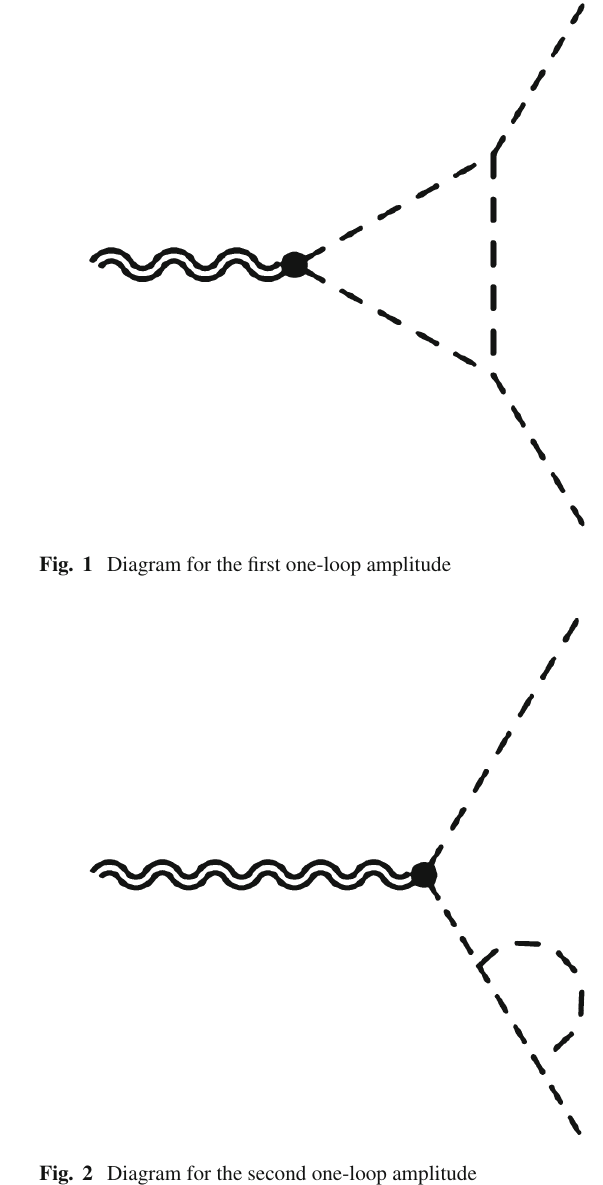
Fig. 2 Diagram for the second one-loop